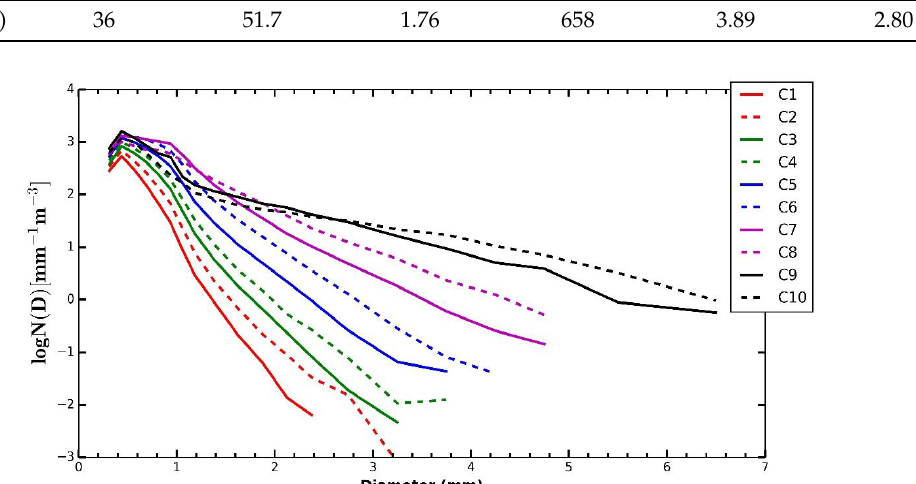
Figure 3. Average Spectra of the RSD, obtained from overall datasets in function to the class of rainfall rate.